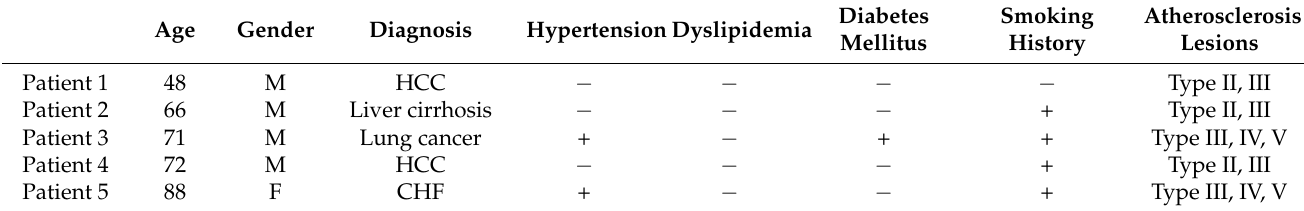
Table 4. Patient characteristics for histological